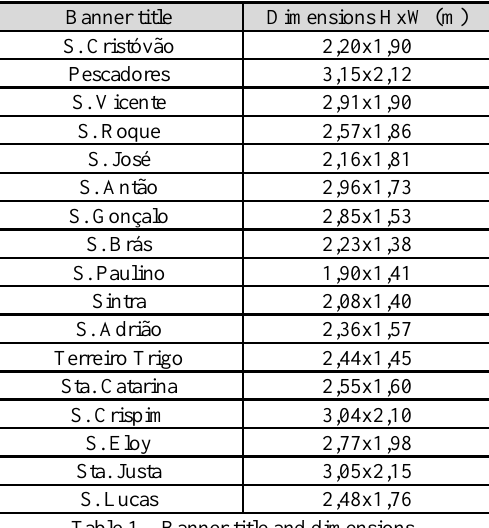
Figure 2 – the seventeen banner and their title These are large dimension objects with a central motif, painted on canvas or printed on paper, reinforced with canvas.